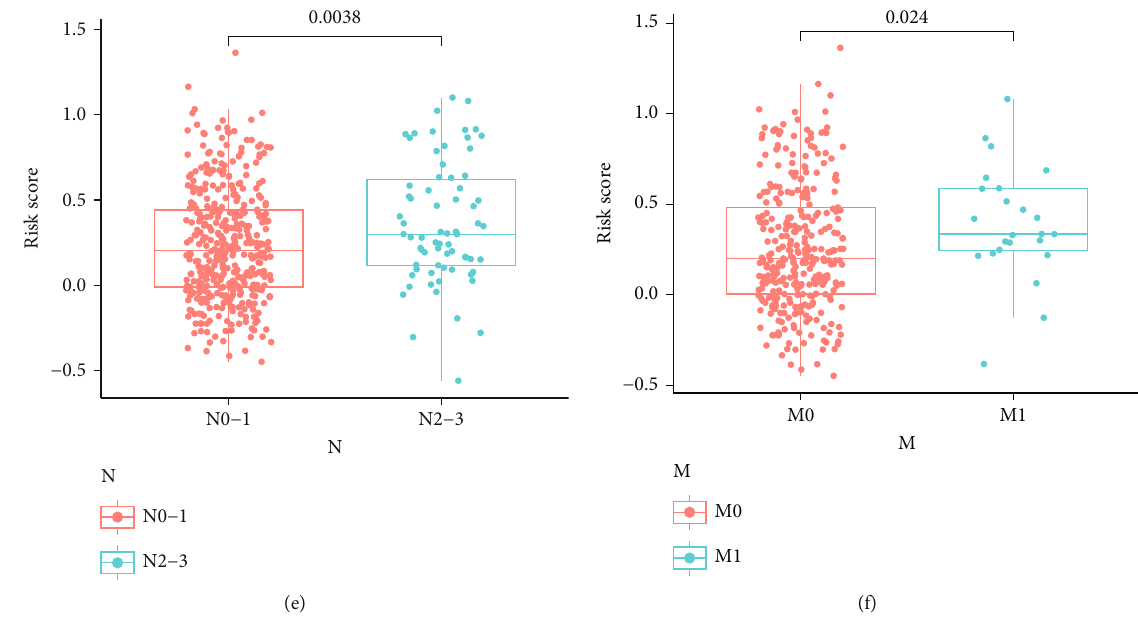
Figure 6: Subgroup analysis of clinical characteristics. (a) Subgroups of age. (b) Subgroups of gender. (c) Subgroups of grade. (d) Subgroups of T stage. (e) Subgroups of N stage. (f) Subgroups of M